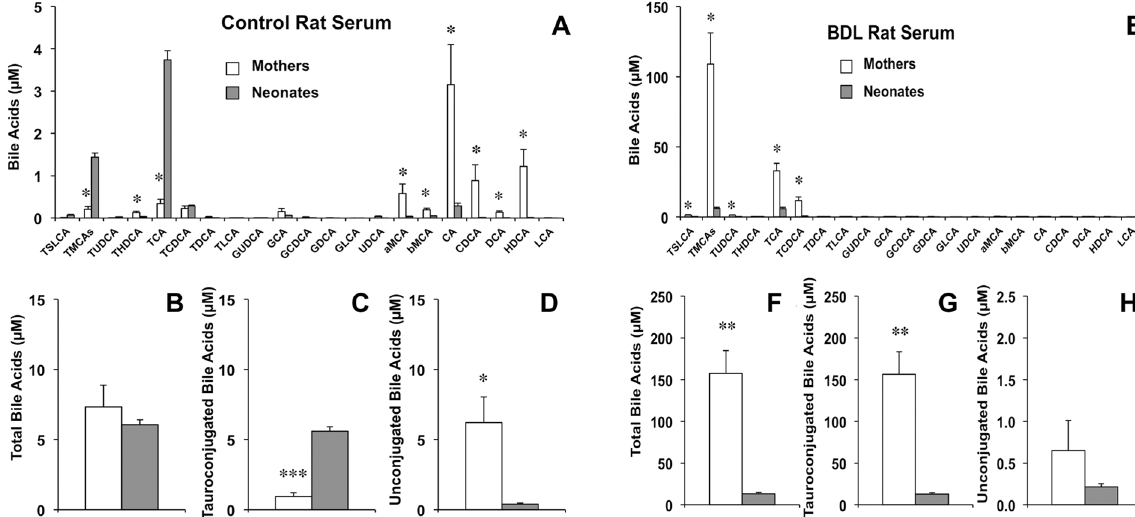
Figure 7. Comparison of serum bile acid concentrations between lactating rats and their offspring. Bile acid concentrations were determined by HPLC-MS/MS in serum samples collected on day 10 after delivery from healthy lactating rats (n = 6) and their pups (n = 14) ( A – D ) or from rats with bile-duct ligation (BDL) from day 14 of pregnancy (n = 6) and their pups (n = 14) ( E – H ). Values (means ± SEM) are expressed as individual bile acid species ( A,E ), total bile acids ( B,F ), taurine-conjugated bile acids ( C , G ) and unconjugated bile acids ( D , H ). * p < 0.05, ** p < 0.01, *** p < 0.001, comparing maternal with neonatal serum by the paired t test.